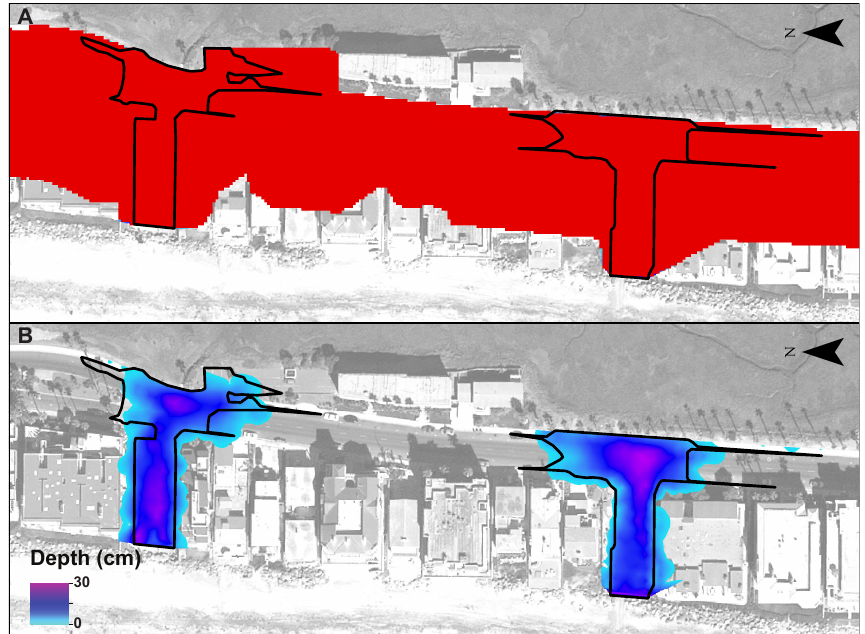
Figure 2. ( A ) A static flood prediction; and ( B ) a hydrodynamic flood prediction using XBeach nonhydrostatic as an overtopping model along with field validation data (black outline). Note depth is unavailable in static predictions and is shown only as extent in